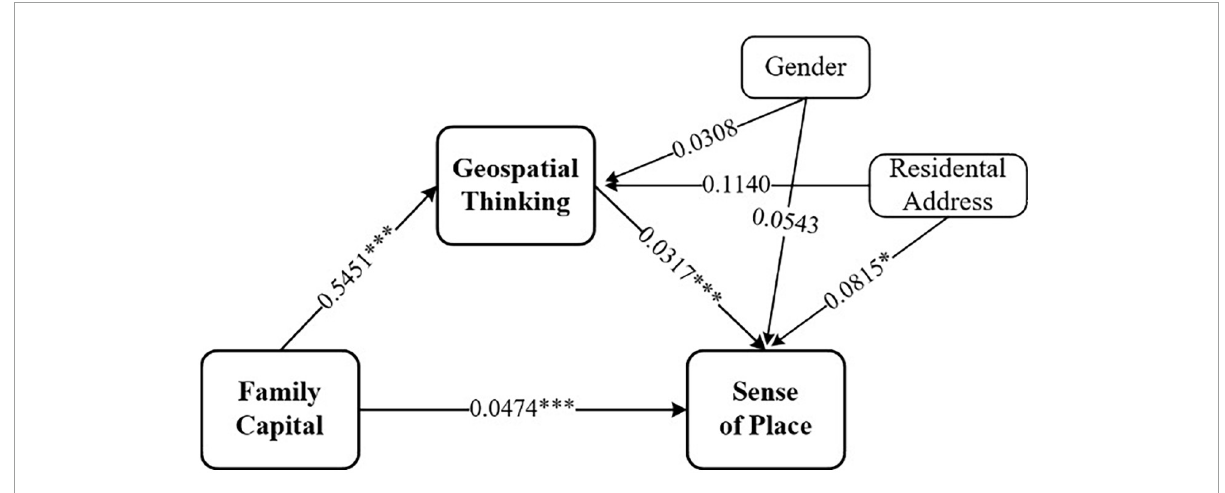
FIGURE2 Mediation model showing relationships between family capital and sense of place and the mediating role of geospatial thinking. *** p < 0.001, * p <